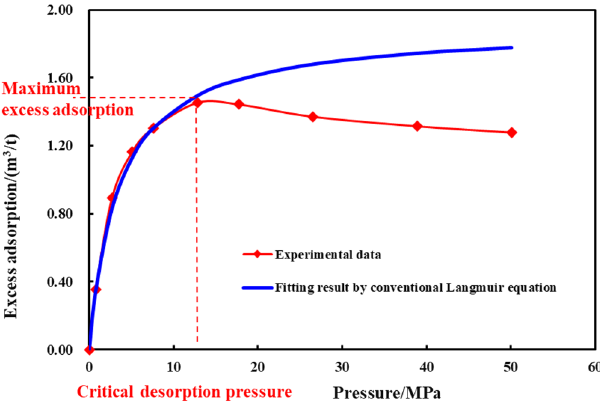
Figure 7. High pressure isotherm adsorption curve for shale 38